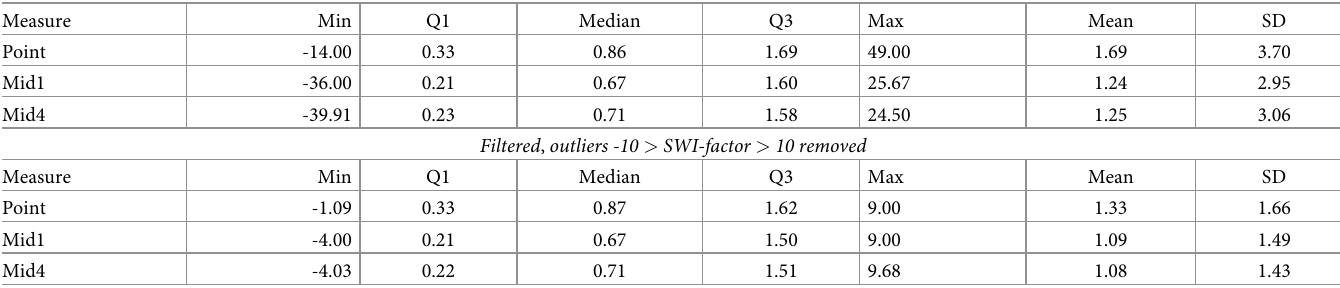
Table 3. Descriptive statistics of weight judgments of a smaller box proportional deviation from the corresponding box that was one size larger.